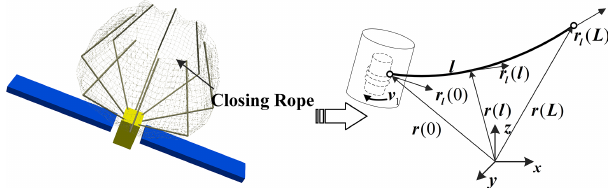
Figure 4. Model of closing